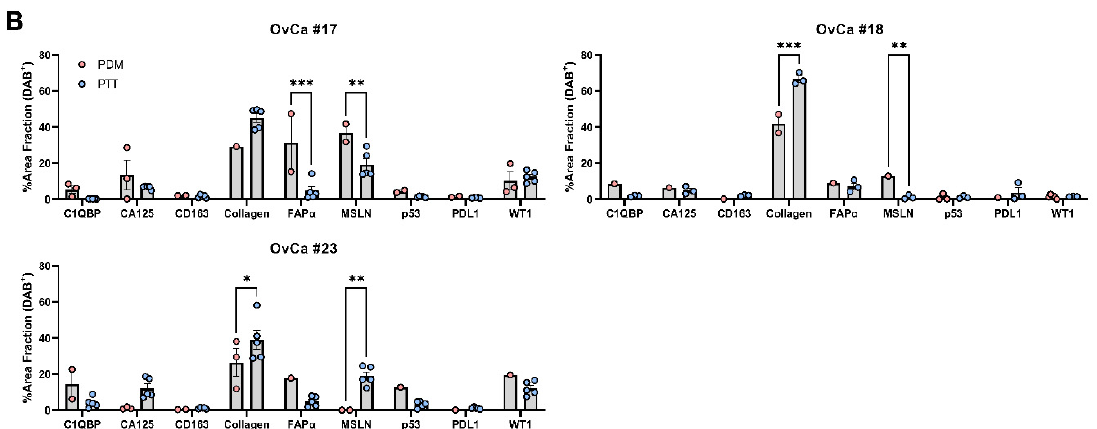
Figure 2. OvCa PDM show histopathological features comparable to corresponding primary tu- mor tissue. ( A ) Hematoxylin and Eosin (H&E) as well as immunohistochemical DAB staining of OvCa PDM (FPPE, 3 µ m) and corresponding primary tumor tissue (PTT) (Cryosections, 4–6 µ m) sections. H&E stainings revealed features of malignant cells (including giant cells with more than one nucleolus, hyperchromatic cells with dark nuclei and high nuclei:cytoplasma ratio) confirming the cancerous origin. Expression of OvCa histotype specific markers (p53, WT1), tumor markers (CA125, MSLN), tumor-associated macrophages (CD163), immune/tumor marker (PD-L1), cancer- associated fibroblasts (FAP α ) and extracellular matrix components (Hyaloronan C1QBP, Collagen I) is shown. Scale bars indicate 500 µ m for PTT; 50 µ m for PDM; 20 µ m for magnifications (PTT and PDM). ( B ) Quantification of IHC stainings for indicated markers within OvCa #17, #18 and #23 PDM and corresponding PTT sections. Shown is the %Area Fraction of positive DAB-stain. For PTT, a minimum of 3 representative regions of interest from tumor areas were used for